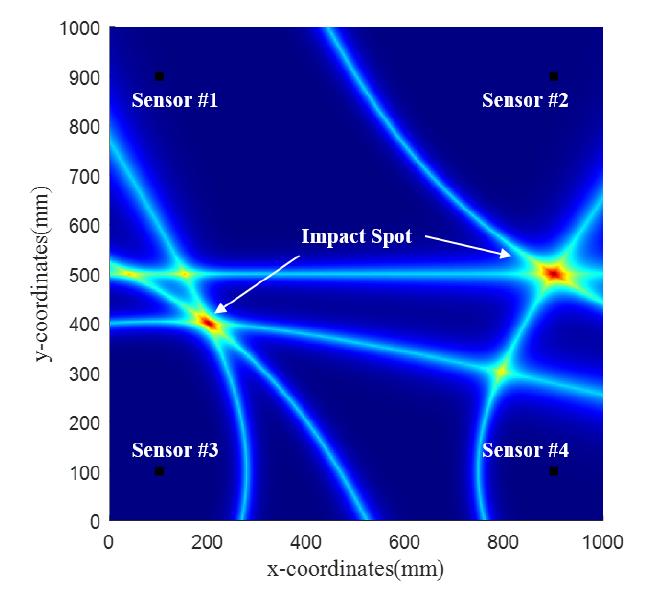
Figure 3. Multipoint localization based on the probabilistic hyperbola